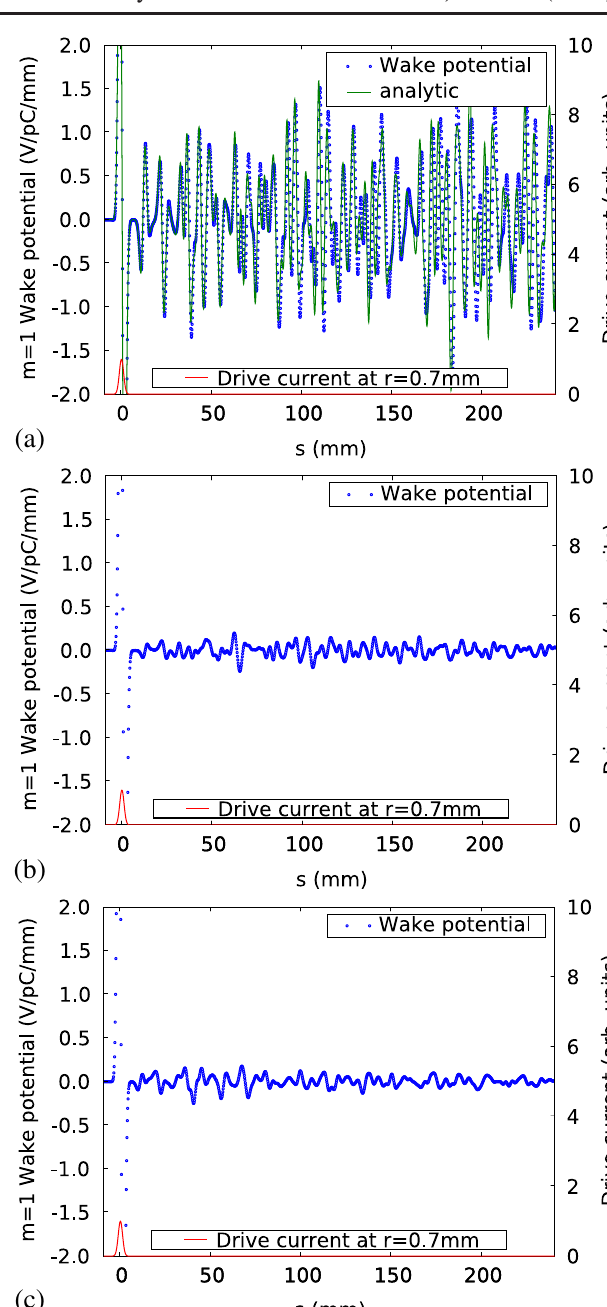
FIG. 5. (Color) Dipole wake potentials (divided by r t ) in the (a) closed pillbox cavity, (b) PhC cavity, and (c) optimized PhC cavity.